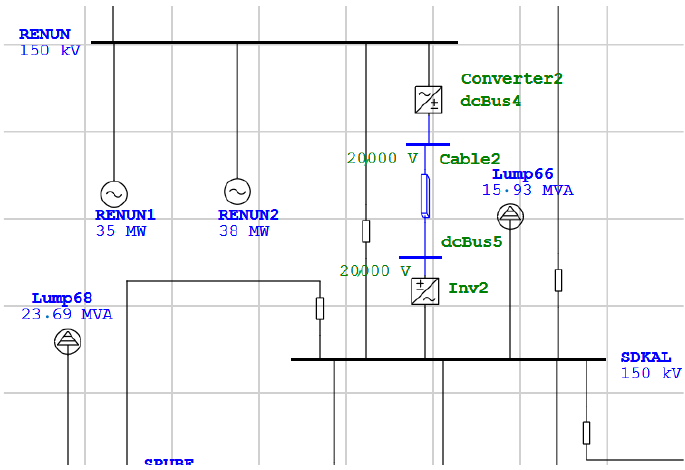
Figure 6. Placement of the HVDC Transmission System at Renun (Bus 66)–Sidikalang (Bus 63).